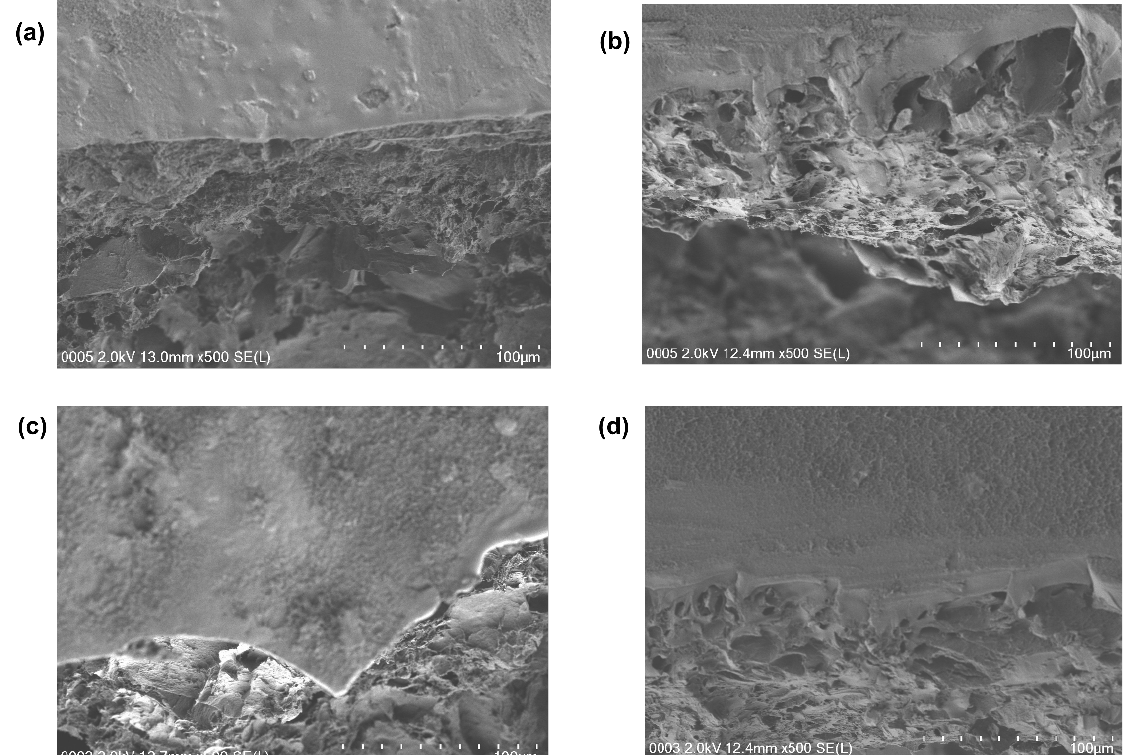
Figure 7. Surface morphology—FESEM micrographs ( a ): PAP1 ( b ) PAP2 ( c ) PAP3 ( d ) PAP4.